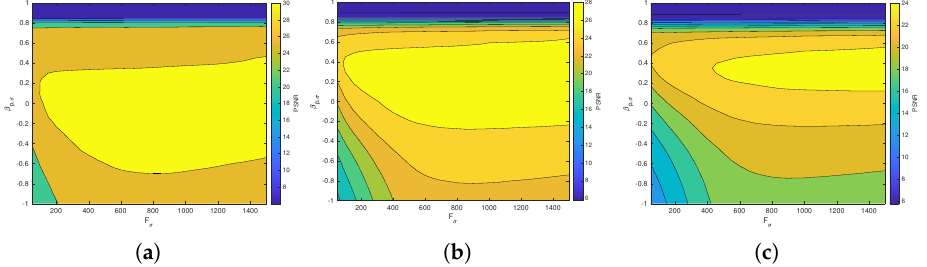
Figure 9. Surface plots for the dependence of the PSNR metric on the values F σ and β p , σ . Coronal view corrupted with Gaussian σ and impulsive noise p . ( a ) σ = 10, p = 0.1. ( b ) σ = 20, p = 0.2. ( c ) σ = 30, p = 0.3.